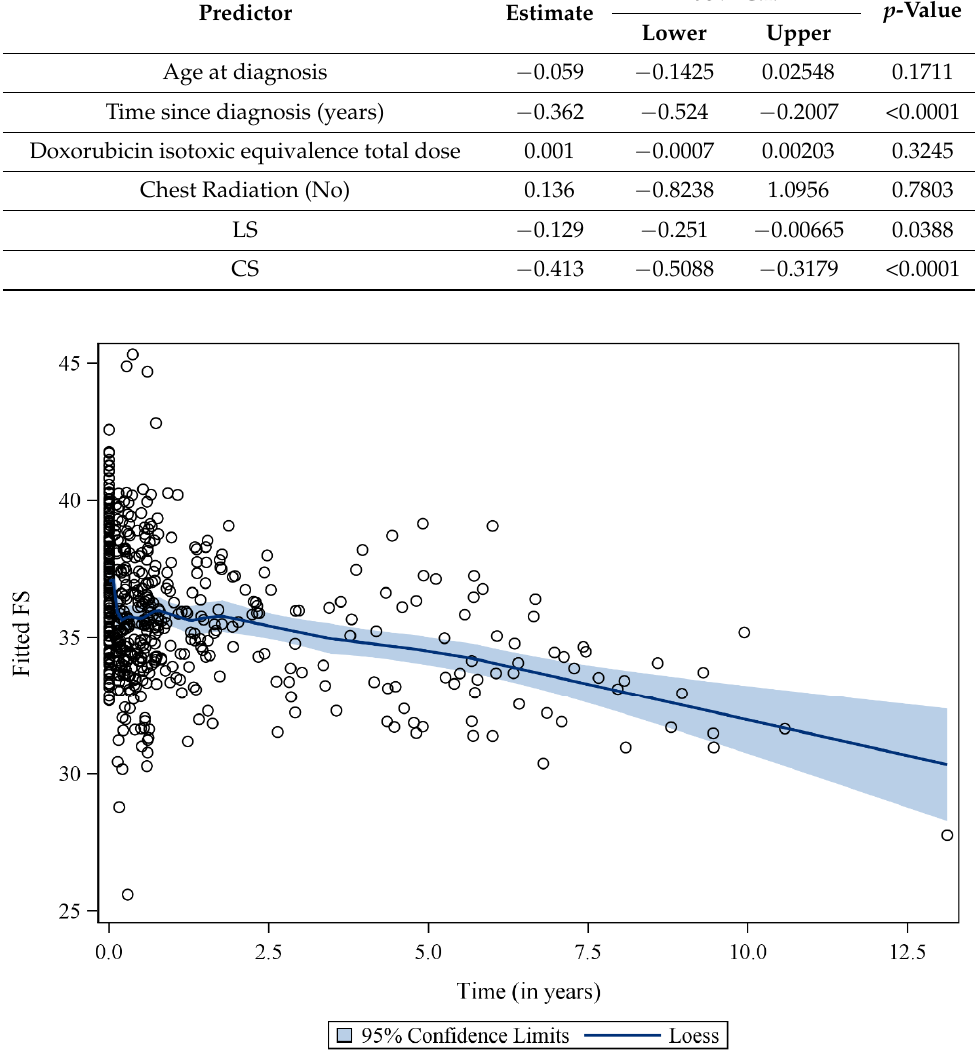
Figure 3. Estimated Fractional Shortening Using a Mixed-Effects Model. Fitted fractional shortening (FS) values (circles) based on a mixed-effects model, including longitudinal strain (LS), circumferential strain (CS), age at diagnosis, time since diagnosis, total doxorubicin isotoxic equivalents, and radiation to a field involving the heart (yes/no) across ‘time since diagnosis’. Loess-smoothed curve of the fitted FS values, along with the corresponding 95% confidence band, is also provided.